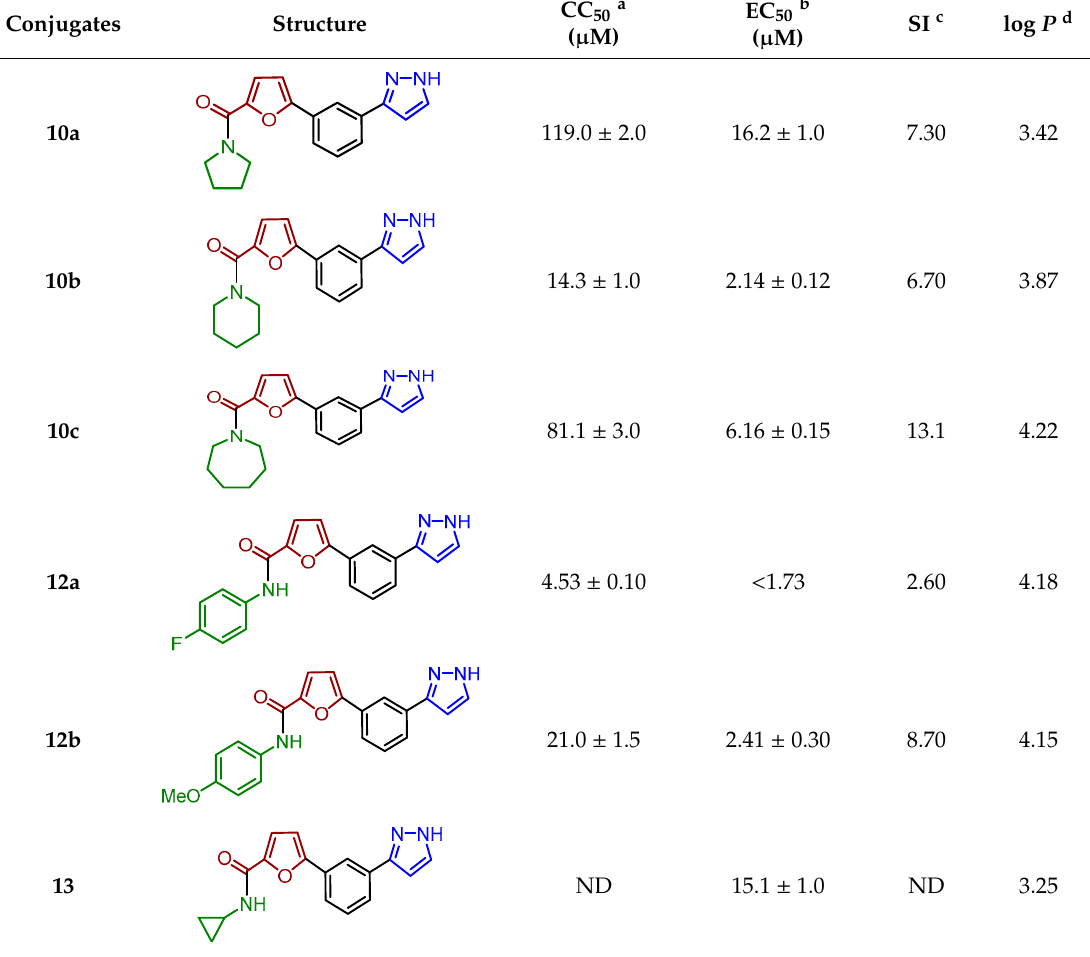
Table 1. Antiviral activity of polycyclic compounds on the replication of EV71 strain BrCr in RD cells. Conjugates Structure